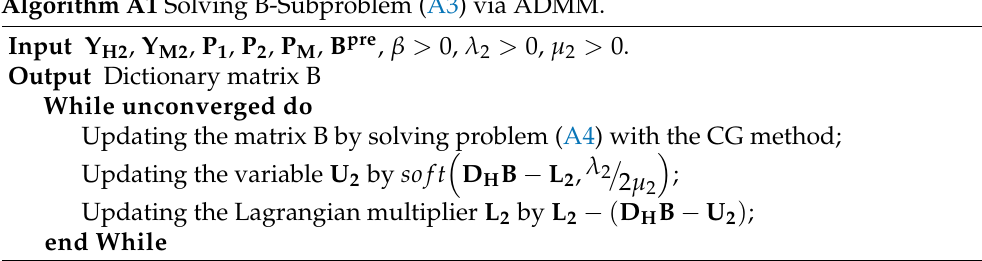
Algorithm A1 Solving B-Subproblem (A3) via